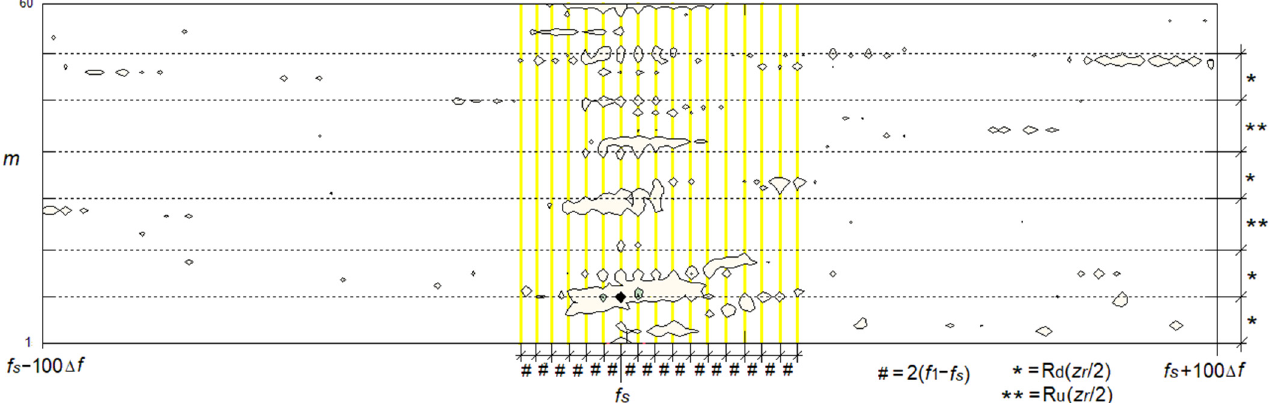
Figure 5. Enlarged central part of F-F image of the frequency spectrum of a healthy motor’s outer casing vibration acceleration ( f P = 2 f s ), with marked reference pattern horizontal and vertical coor-